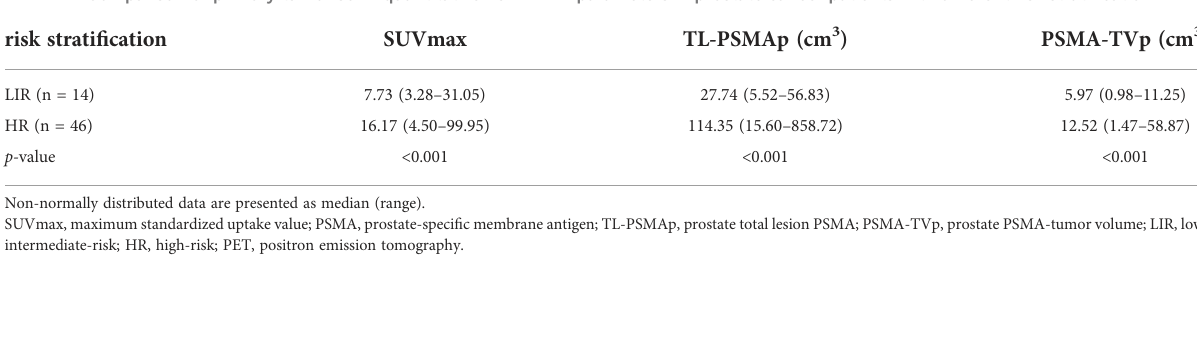
TABLE 2 Comparison of primary tumor semi-quantitative PSMA-PET parameters in prostate cancer patients with different risk strati fi cation. risk strati fi cation